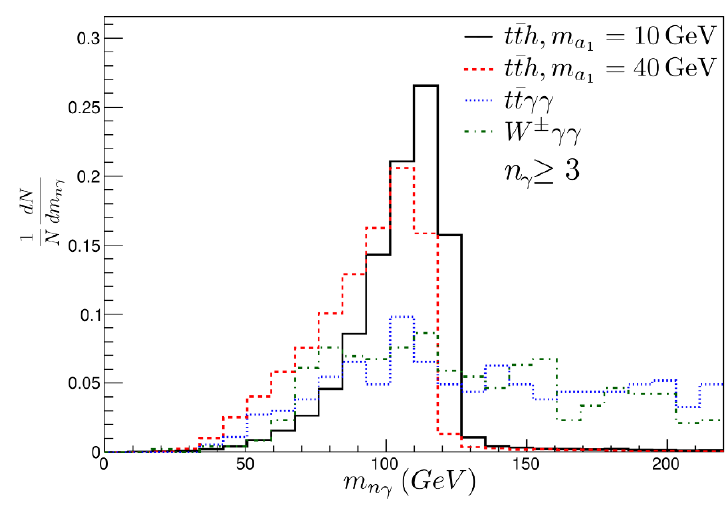
Figure 3 . Invariant mass of photon system with at least three photons subject to photon selec- tion